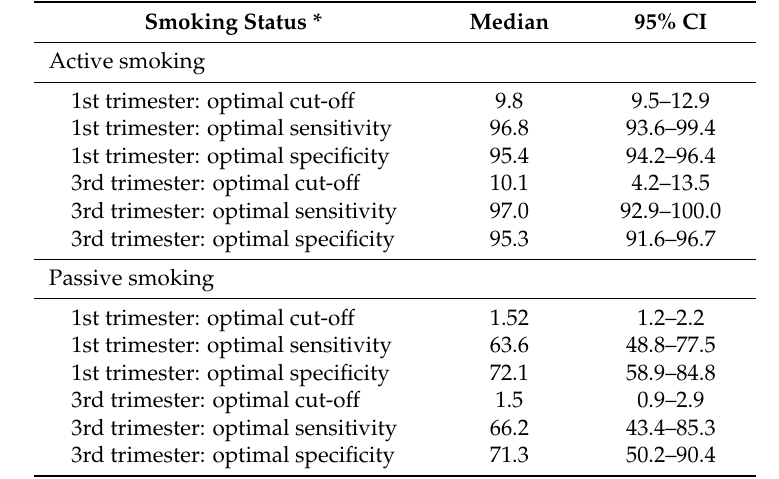
Figure 1. Receiver Operating Characteristic (ROC) curves for active smoking in the first and third trimesters. Table 3. Variability of optimal cotinine cut-off points for maternal smoking status, and corresponding sensitivity and specificity of cotinine tests using the optimal cut-offs to predict reported smoking status.